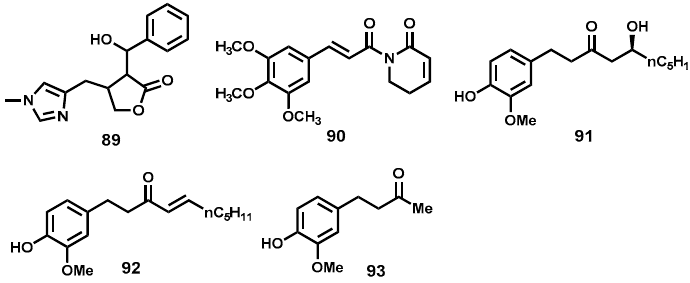
Figure 14. Antischistosomal alkaloids and ginger-derived metabolites.